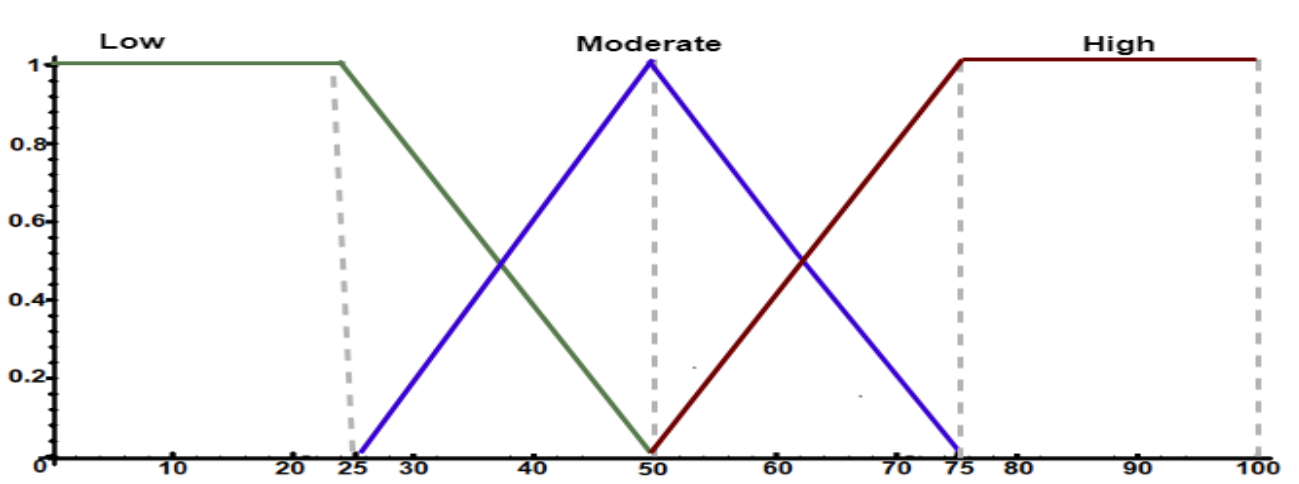
Figure 5. Fuzzy sets to model behavior change detection